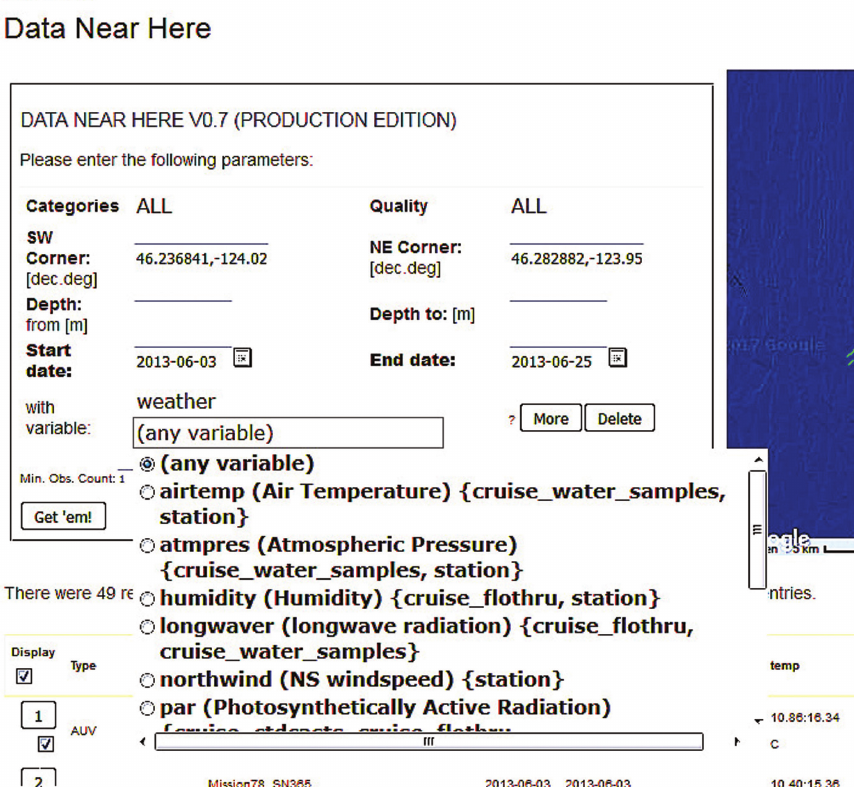
Fig. 3: Interface for data exploration provided by DNH